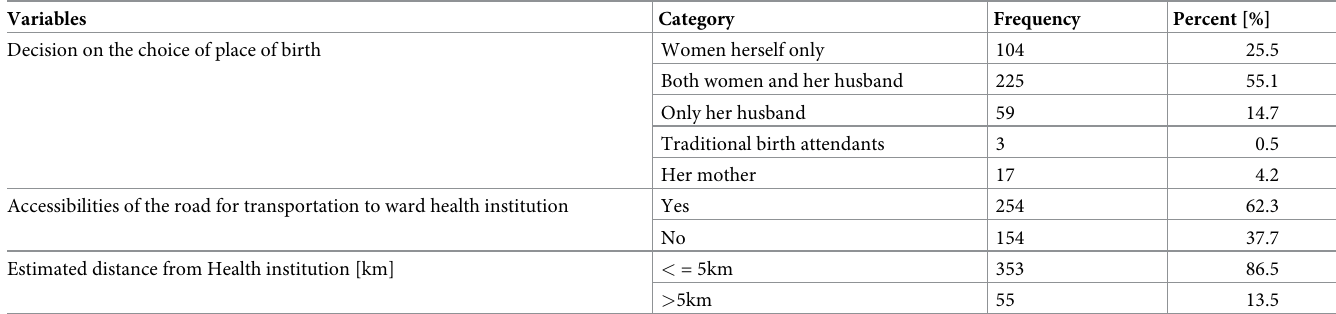
Table 2. Social and service-related characteristics of study participants in Arba Minch health demographic surveillance site, May 2021. Variables